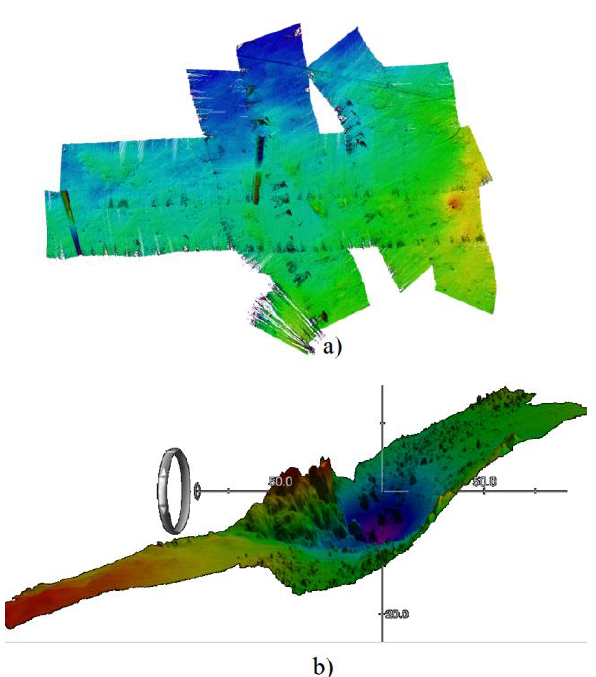
Figure 3. Sea-bottom surface representation of the two study sites: a) Rimouski control zone; b) Chaudière rive estuary